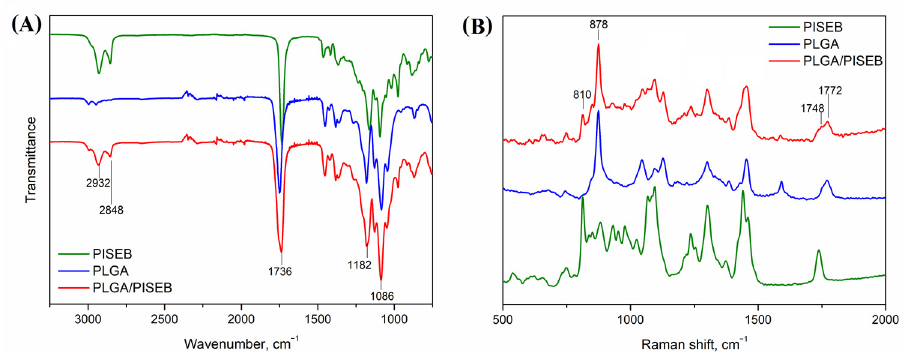
Figure 3. IR ( A ) and Raman ( B ) spectra of a drop-casted PISEB layer, electrospun PLGA and PLGA/PISEB scaffolds.